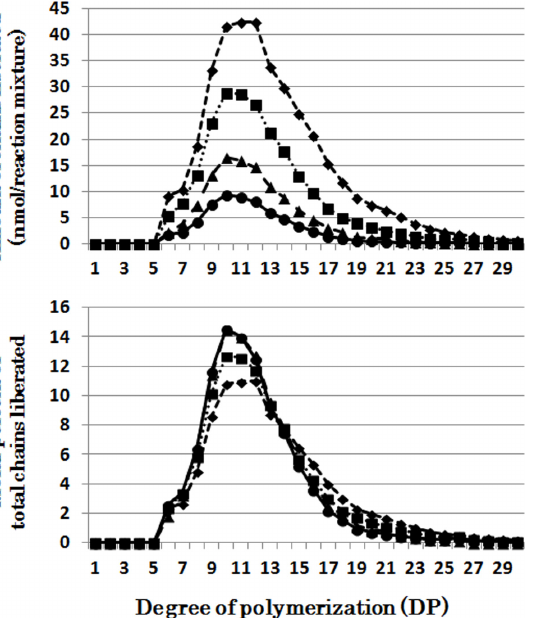
Fig 2. Chain-length preference of rice isoamylase1 (OsISA1) in debranching amylopectin. Upper panel shows the amount of chains liberated after enzymatic reaction with OsISA1 and amylopectin for 5 ( ● ), 10 ( ▲ ), 30 ( ■ ), and 60 ( ♦ ) min, respectively. Lower panel shows the molar percentage of each liberated chain to the total liberated chains.